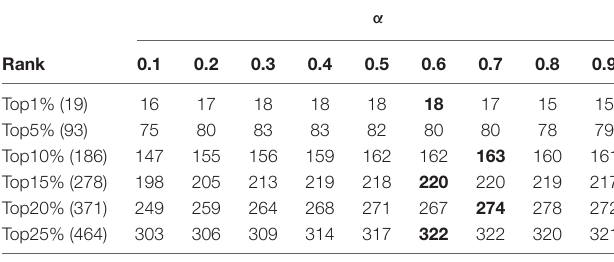
TABLE 2 | Influence of parameter α on the effect of initial iteration algorithm in Gavin database.